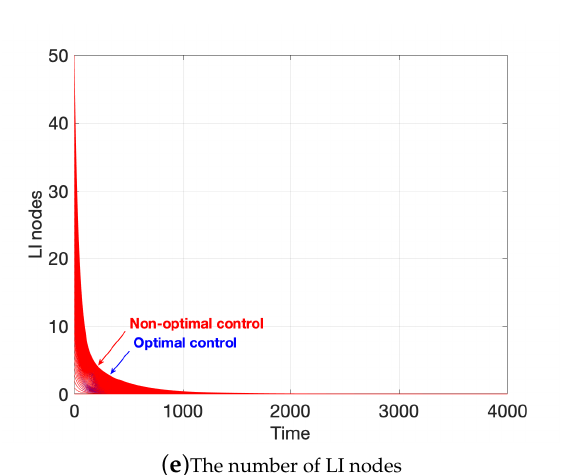
Figure 7. Evolution of state variables under various controls in the case of R 0 <